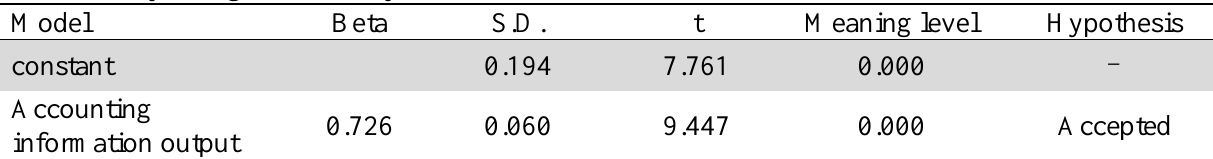
The summary of regression